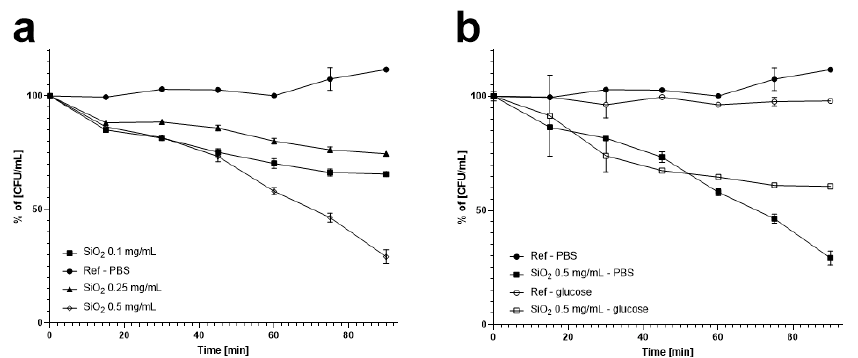
Figure 2. Diagrams of the Oenococcus oeni (DSM7008) viability after bacteria exposure to the silica nanospheres (SiO 2 ) in phosphate-buffered saline (PBS) solution ( a ) and glucose ( b ) under stirring.